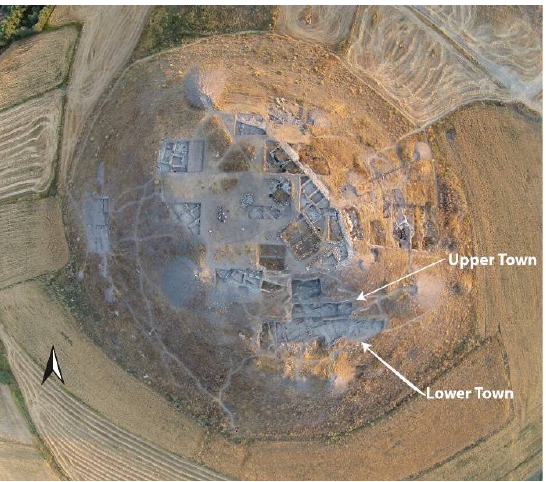
Figure 3. Aerial view of Çadır Höyük showing location of Lower and Upper (Chalcolithic) Towns on southern slope.